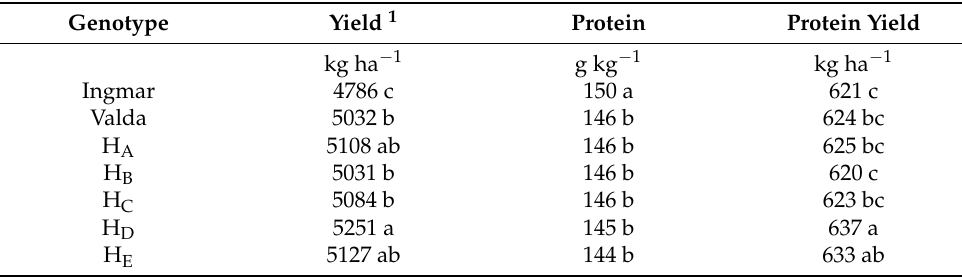
Table 8. Yield, protein, and protein yield means of seven hard red spring wheat genotypes in 2019 and 2020 combined across environments (location-year) in North Dakota, USA.